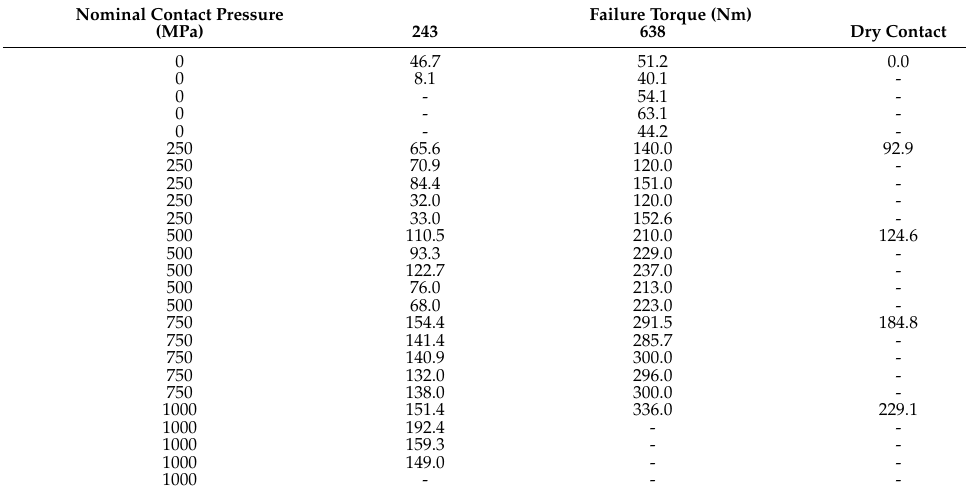
Table 2. Experimental failure torque.